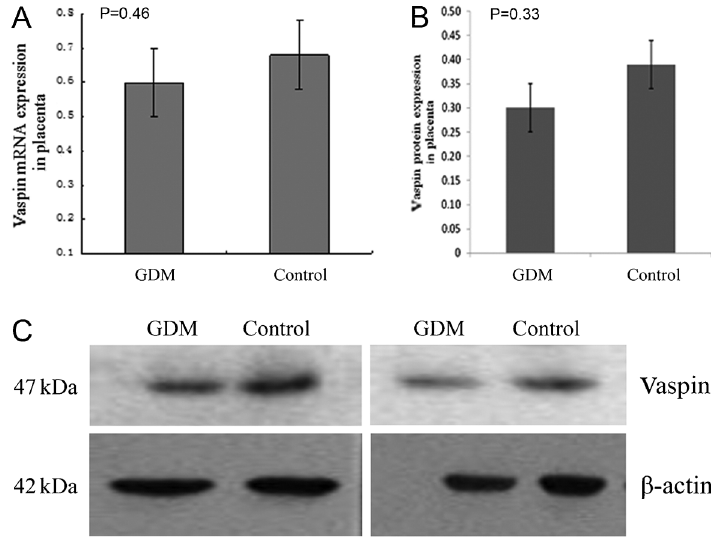
Figure 2. Real-time RT-qPCR and Western blotting were performed on gestational diabetes mellitus (GDM) and normal glucose tolerance (NGT) term placentas. A , Quantification of differences in vaspin mRNA expression between the two groups; B and C , quantification of differences in vaspin protein expression between the two groups. b -actin served as an internal control. One-way ANOVA was used for statistical analysis.